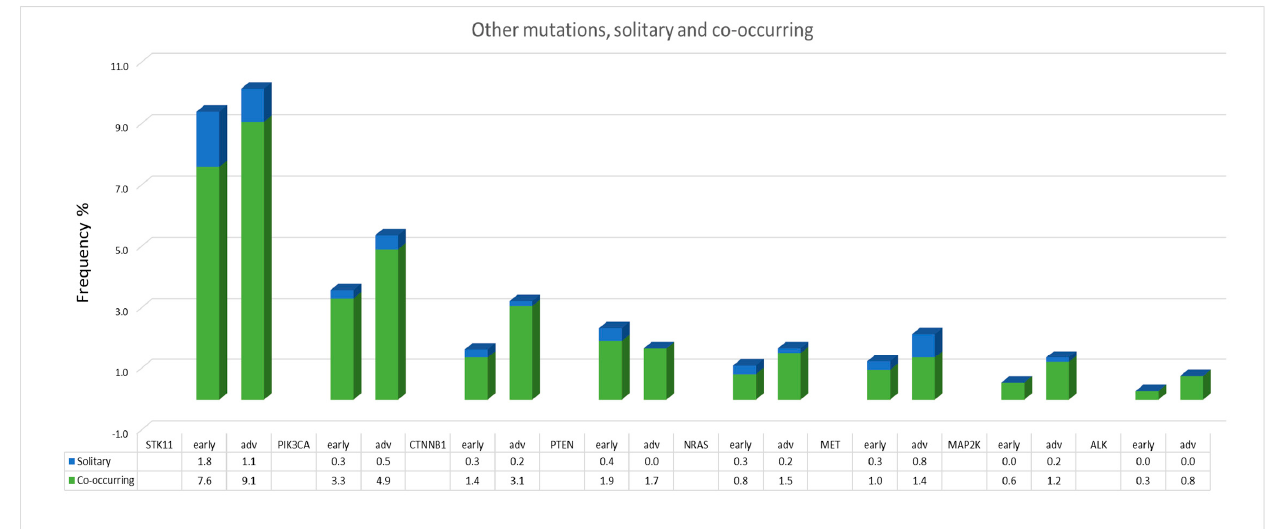
Figure 4. Frequencies of detected single and co-occurring mutations.